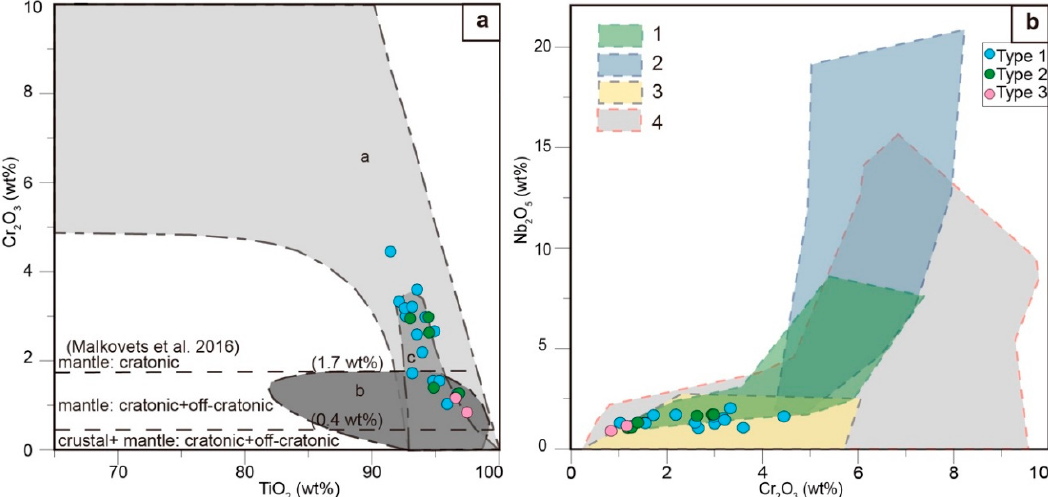
Table 3. Representative analyses of